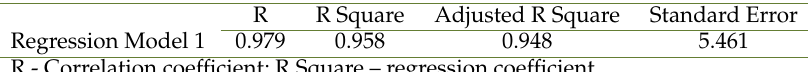
Table 6. Model summary of regression Analysis